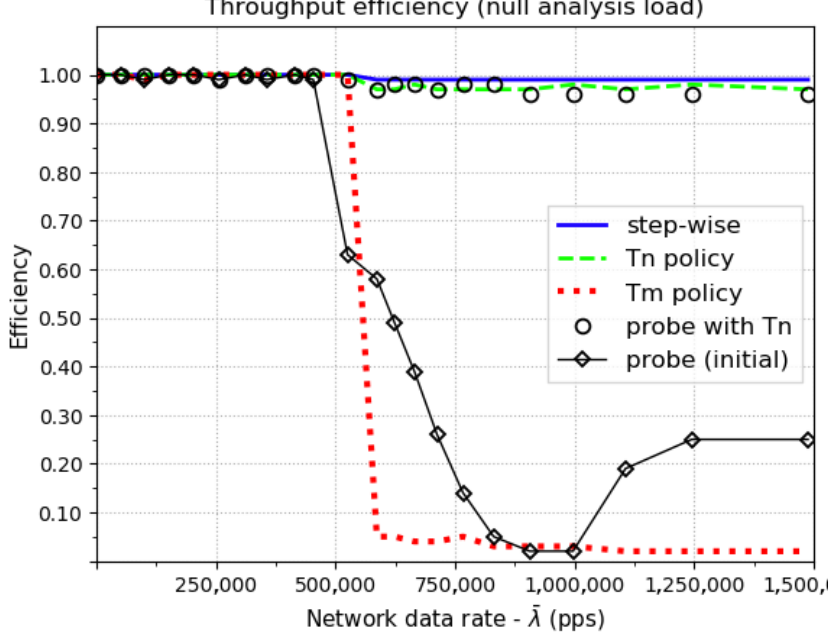
Figure 13. Comparison in terms of throughput efficiency with respect to the optimal